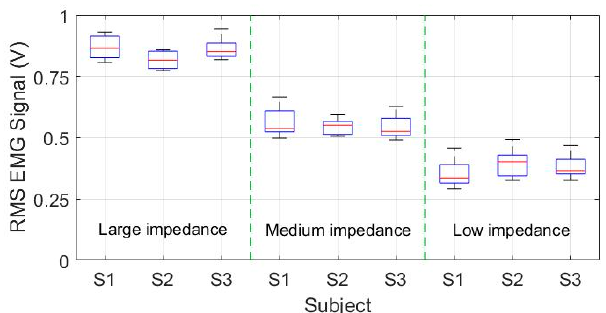
Figure 11. The results of the intention-based experiments with different impedance parameters and different volunteers in a single trial. ( a ) The experimental results of S1. ( b ) The experimental results of S2. ( c ) The experimental results of S3.